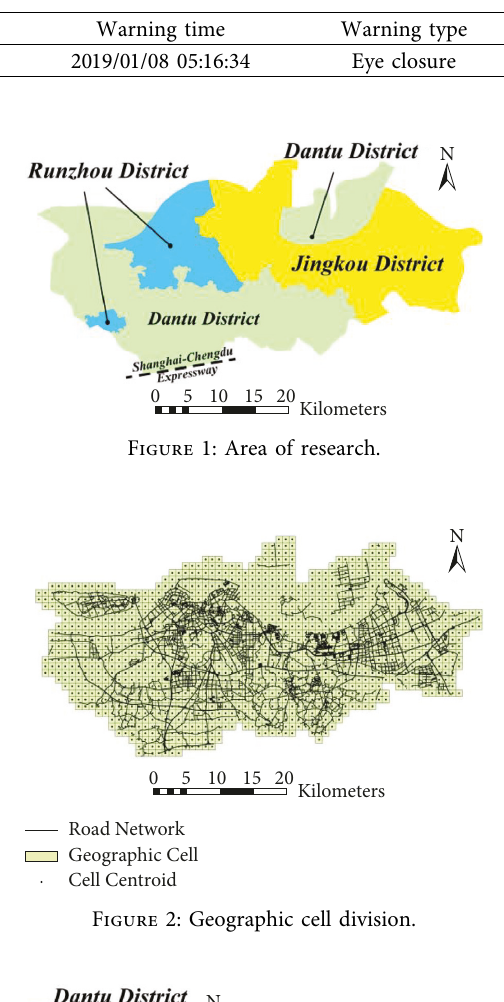
Table 1: Bus warning data.